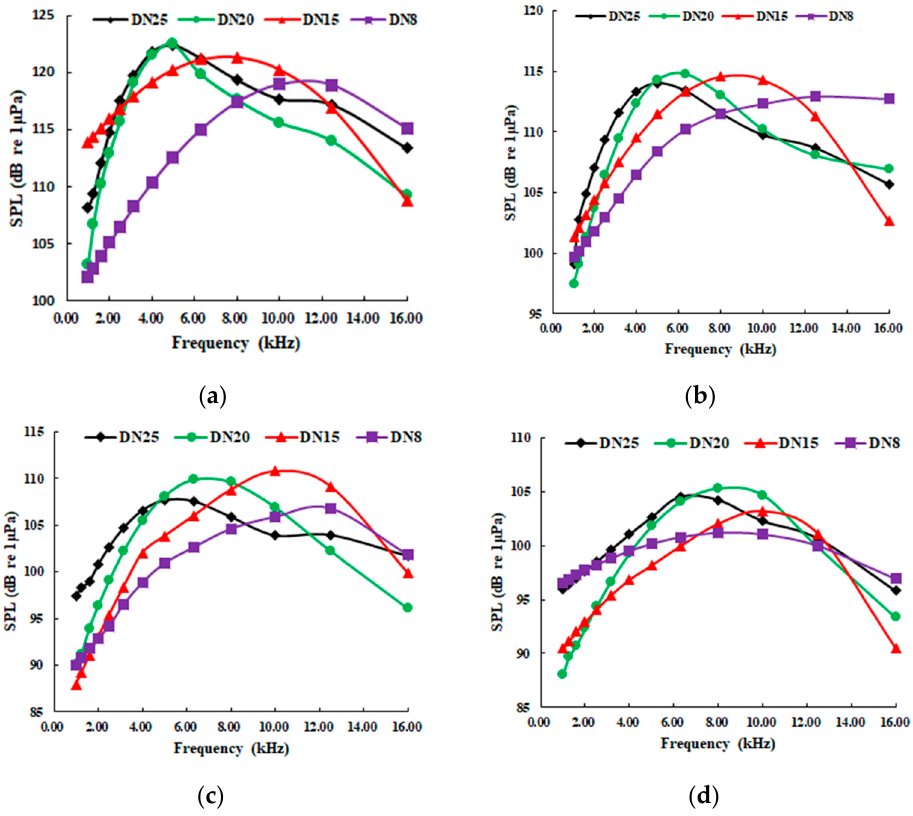
Figure 16. Radiation sound pressure levels with different leak diameters. (a) 0.30 MPa; (b) 0.25 MPa; (c) 0.20 MPa; (d) 0.15MPa.